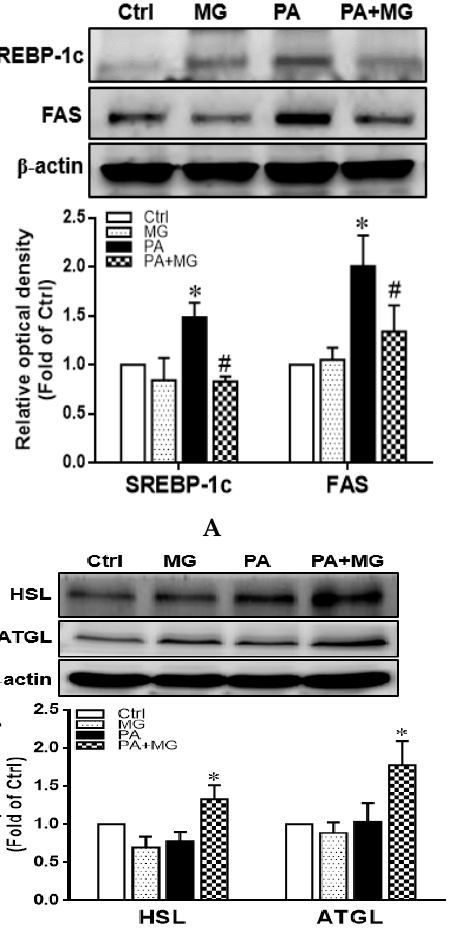
Figure 4. Effects of magnolol (MG) treatment on cell viability and lipid accumulation in steatotic HepG2 cells. ( A ) Cell viability of HepG2 cells treated with MG (0–32 μ M) for 24 h expressed as optical density percentage; ( B ) photomicrograph of Oil Red O staining (20×); ( C ) colorimetric assay for quantification; ( D ) triglyceride levels of the supernatant fraction in HepG2 cells. Data are expressed as mean ± SEM, n = 4. * p < 0.05 vs. Ctrl; # p < 0.05 vs. palmitic acid (PA).